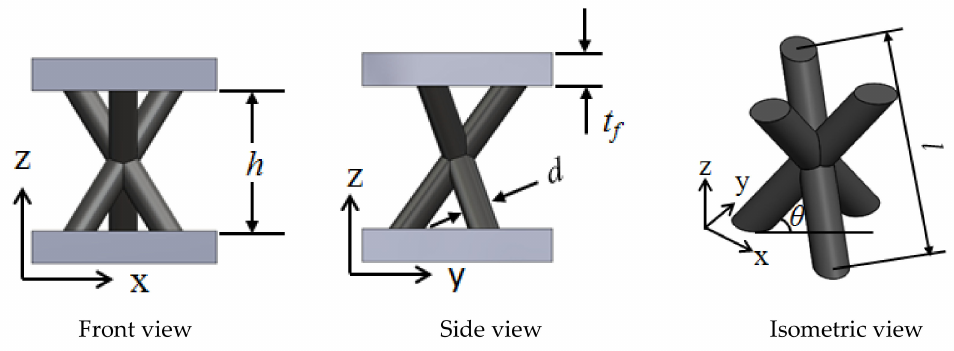
Figure 1. Front, side and isometric views of Kagome unit structure.